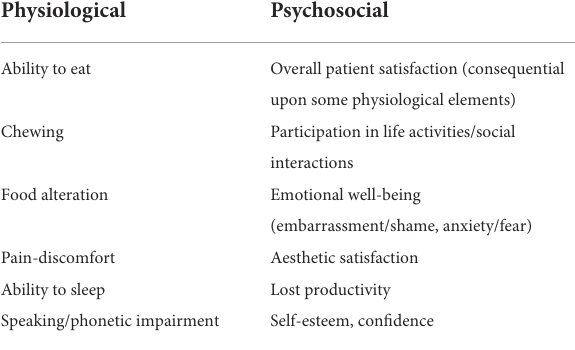
TABLE 3 The key domains for measuring the physiological and psychosocial dimensions of oral